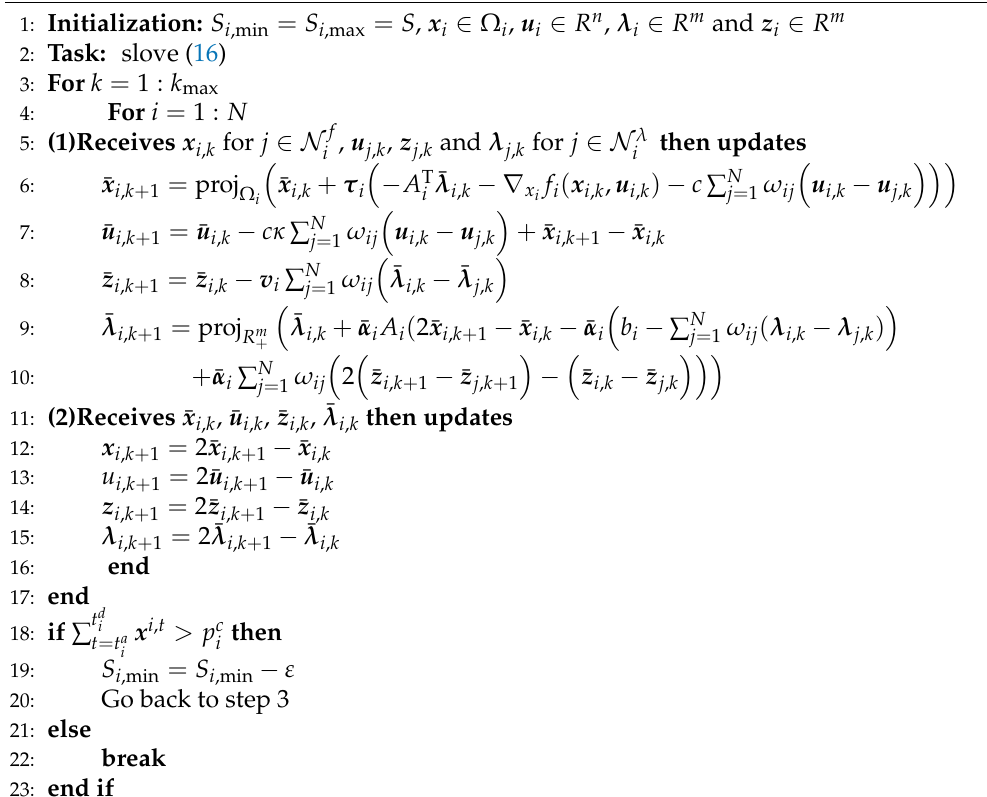
Algorithm 1 : Distributed charging strategy with reflected forward-backward